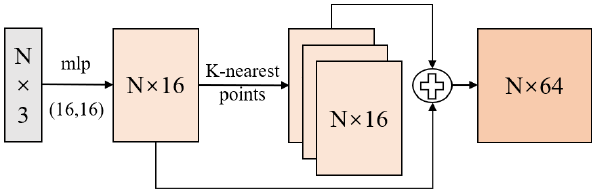
Figure 7. Network structure of the NIA module.